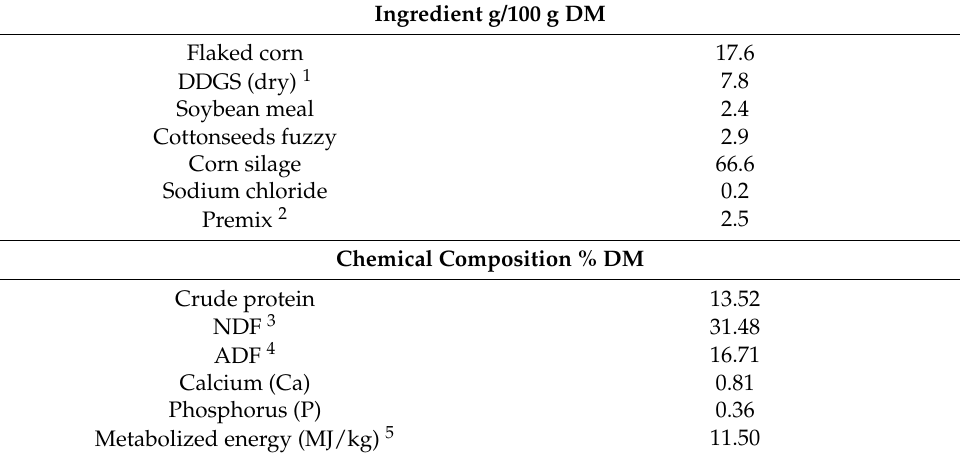
Table 1. Ingredients and characteristics of the total mixed